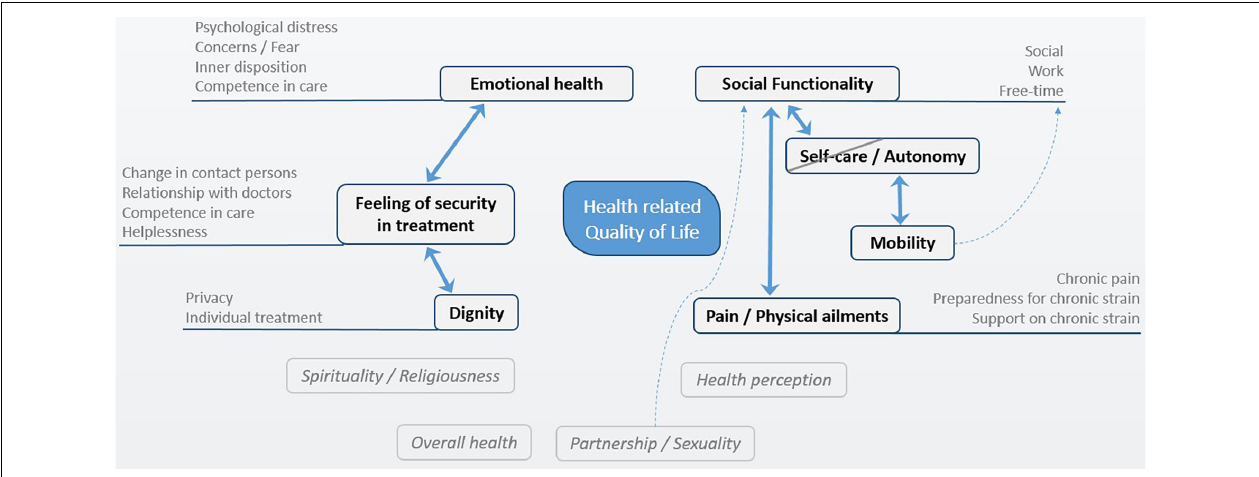
FIGURE 1 | Qualitative content analysis: Categories of HrQoL in cancer